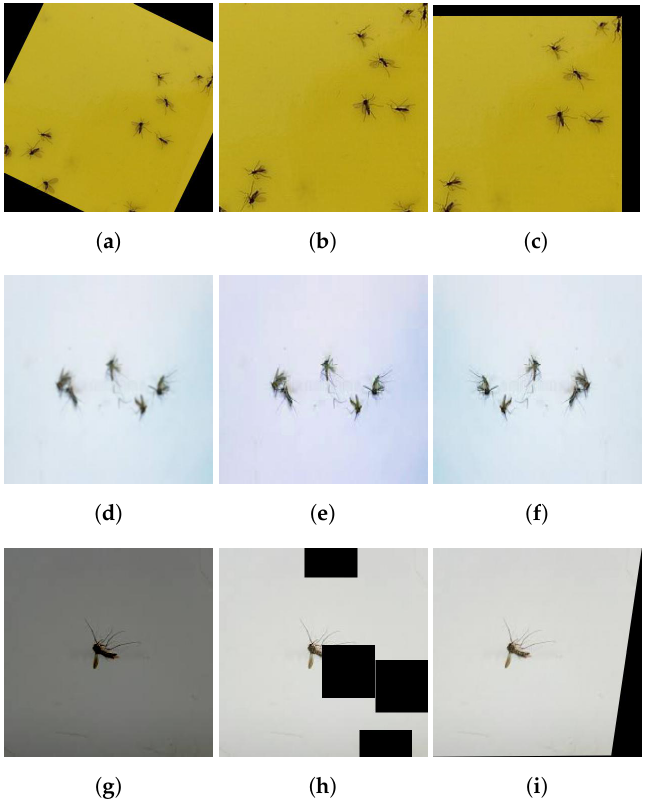
Figure 6. Sample of augmented image. ( a ) Rotation. ( b ) Scale. ( c ) Translation. ( d ) Blur. ( e ) Enhance color. ( f ) Flip. ( g ) Brightness. ( h ) Cutout. ( i )